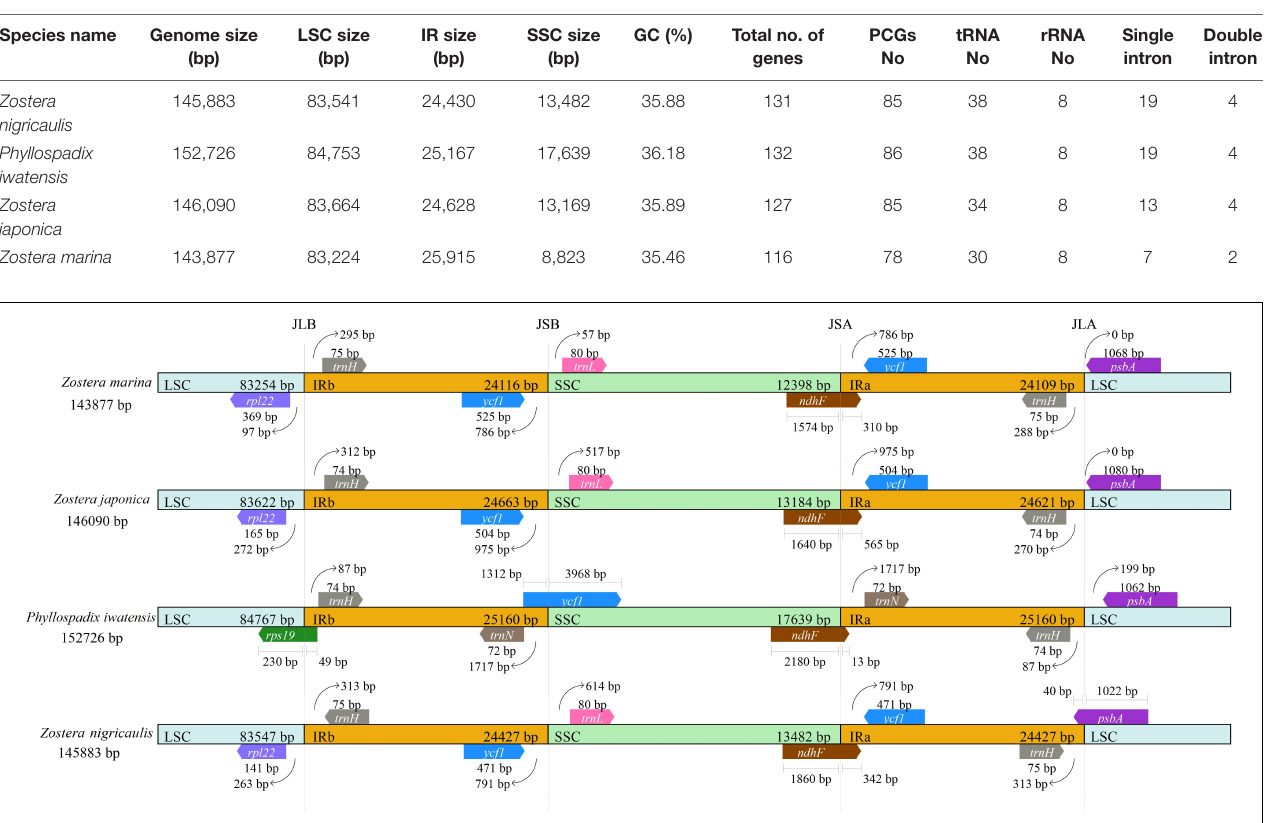
TABLE 1 | Chloroplast genome features of four Zosteraceae species.